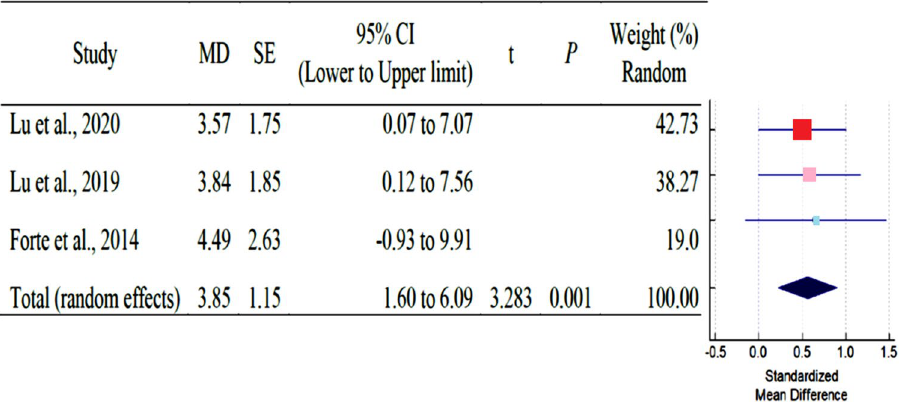
Figure 6. Forest plot for the outcome of PPR-S-PPL.